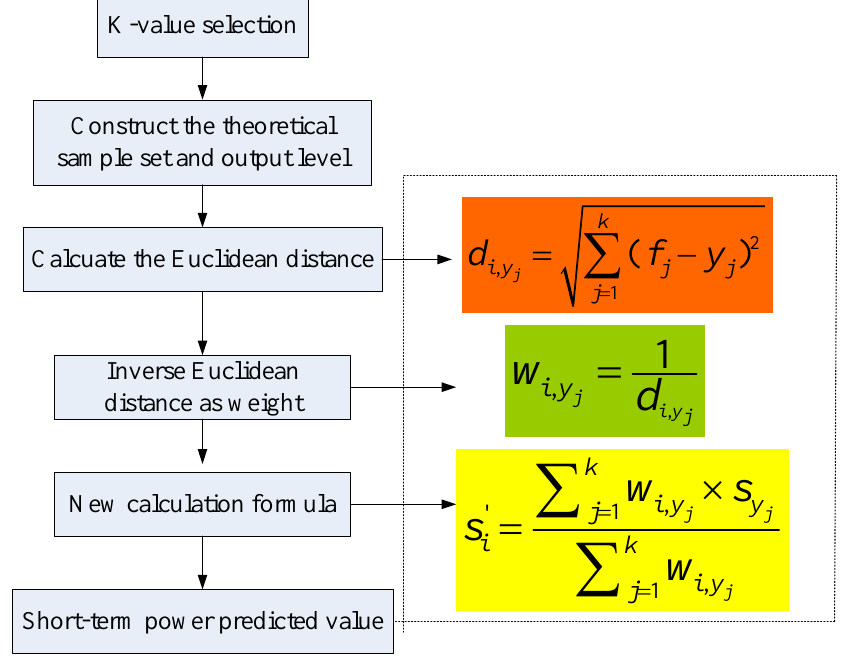
Figure 2. The flowchart of the proposed W-K-NN algorithm .